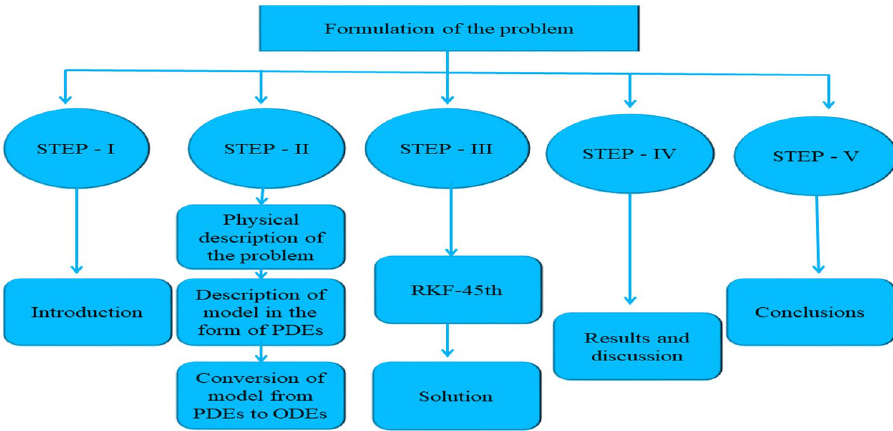
Figure 2. Formulation of the problem.